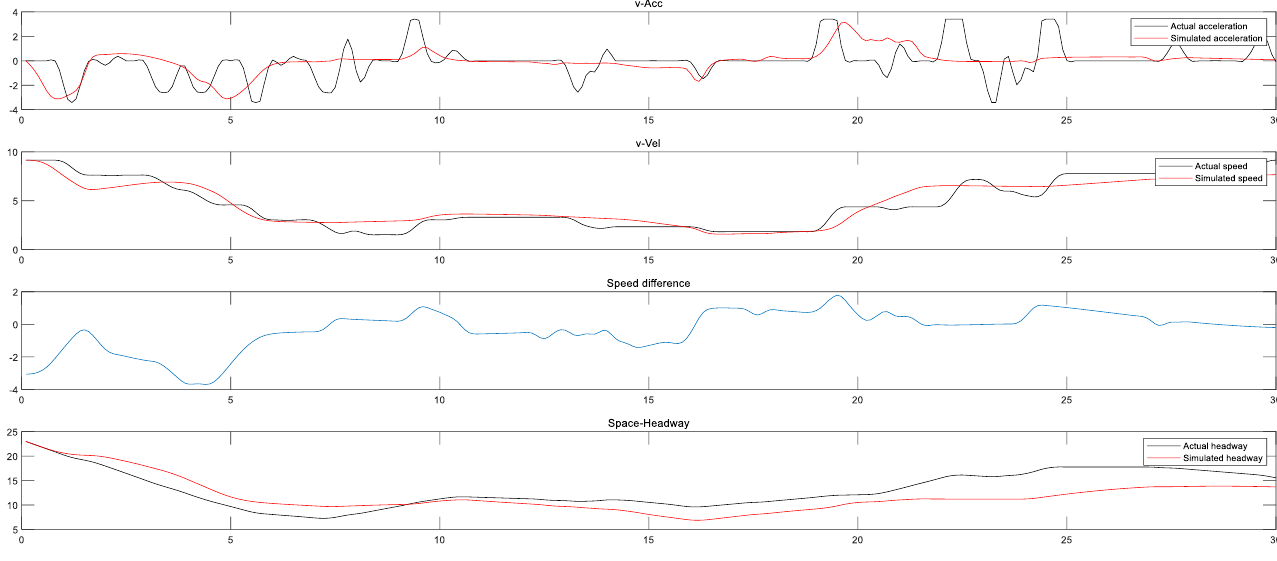
Figure 11. Simulation results of the GA-BP fitted stimulus-response model.